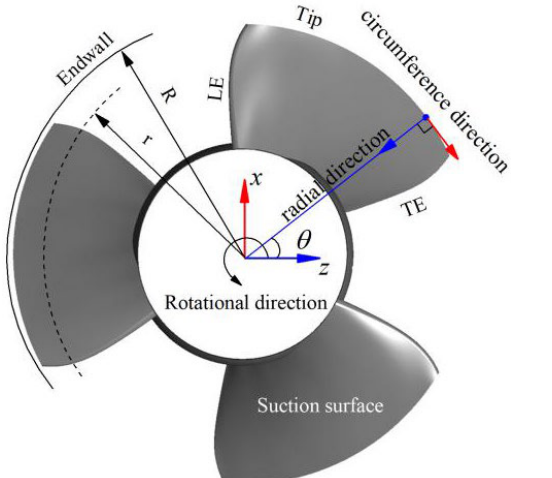
Figure 2. ( a , b ) Geometric definition of the impeller.